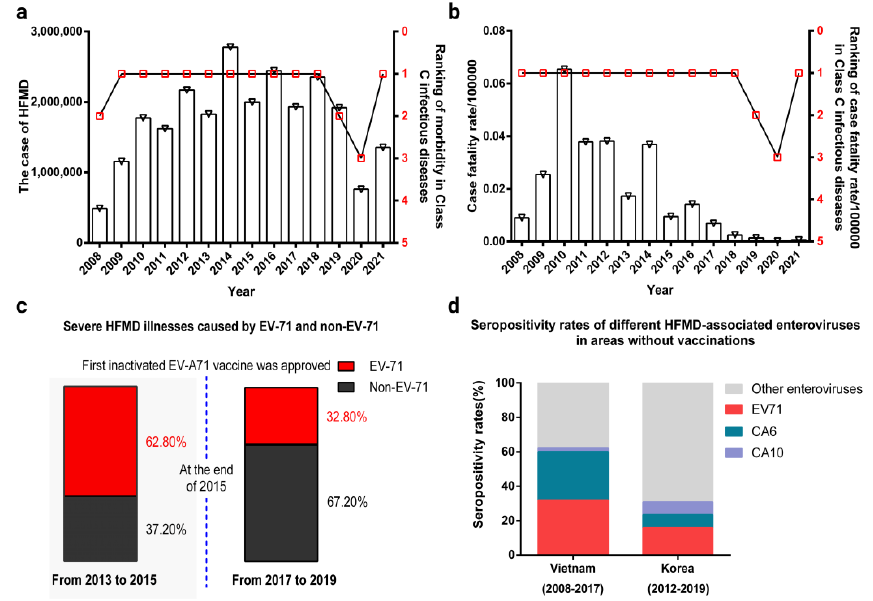
Figure 1. The epidemiological data of HFMD. ( a ) The number of HFMD cases in China from 2008